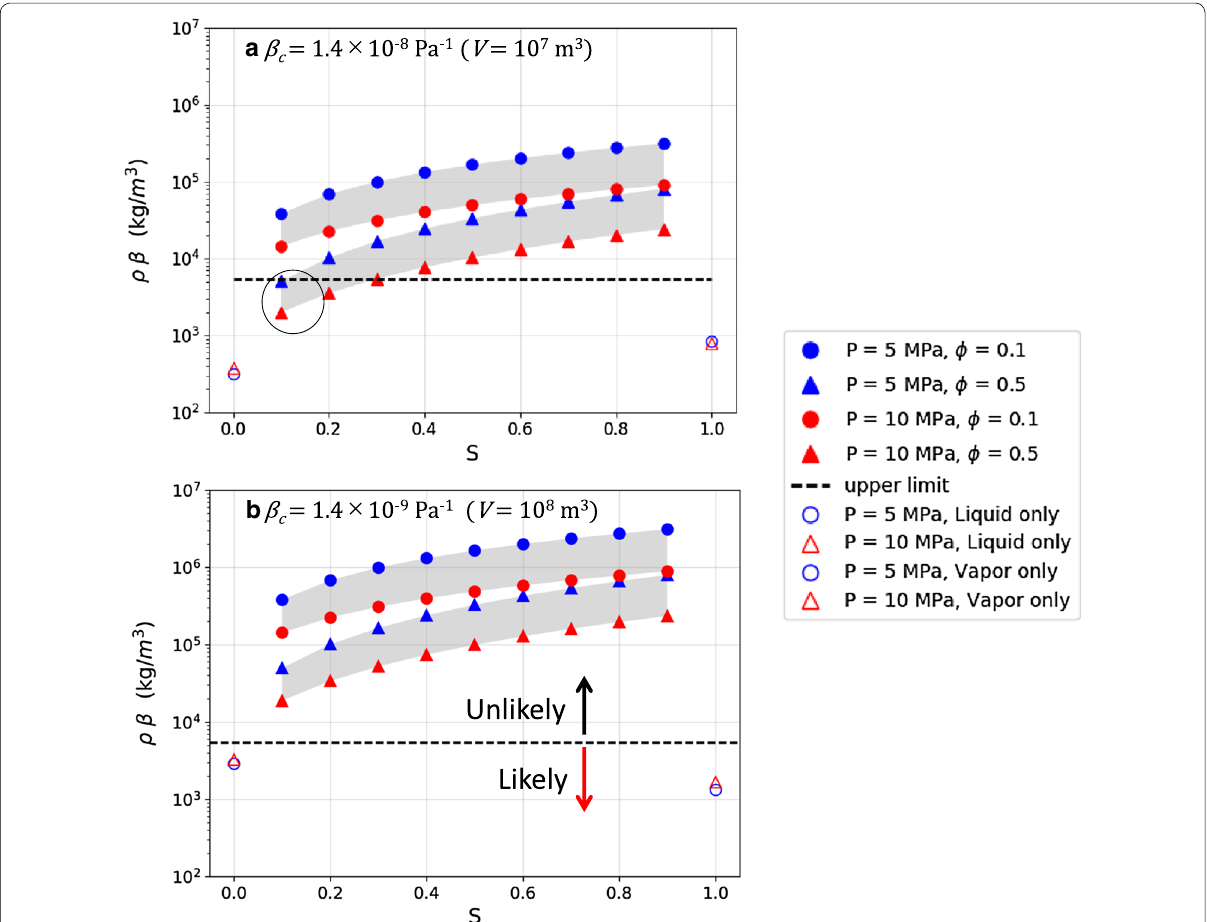
Fig. 9 Calculated ρβ values for the shallow reservoir. Plots are made for each of two end members of β c : a β c at b β c 1.4 10 − 9 Pa − 1 ( V 10 8 m 3 ) (see also Additional file 1: Text S2). ρβ are computed as a function of S , (0.0 = × = of these parameters setting are described in Additional file 1: Text S1. Solid and open symbols correspond to two-phase and single-phase state, respectively. Solid circles and triangles correspond to host rock porosity φ correspond to conditions of lithostatic and hydrostatic pressure at the 500-m depth, respectively. A black dashed line shows an upper limit value of ρβ , which is derived from observations. Gray-shaded area indicates possible range of allowable ρβ values, within which even calculated values with pressure drop should